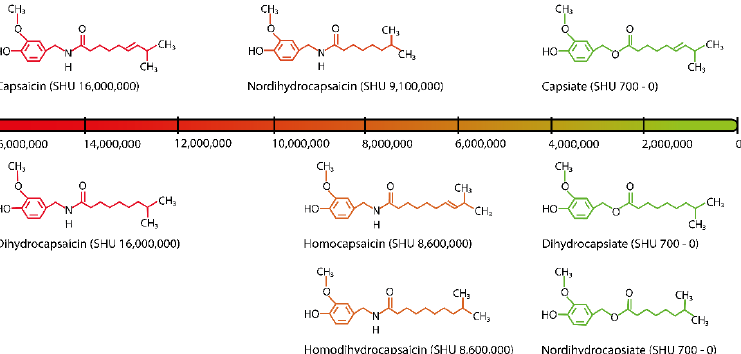
Figure 1. Scoville scale and molecular structure for the main capsaicinoids and capsinoids produced by species of Capsicum genus.